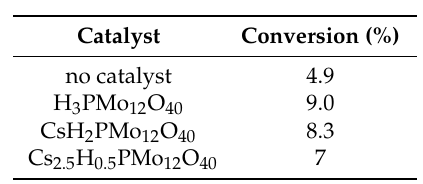
Table 1. Conversion after 180 min in the esterification of acetic acid with ethanol catalyzed by various PMo 12 catalysts synthesized in Y zeolite a . Adapted from